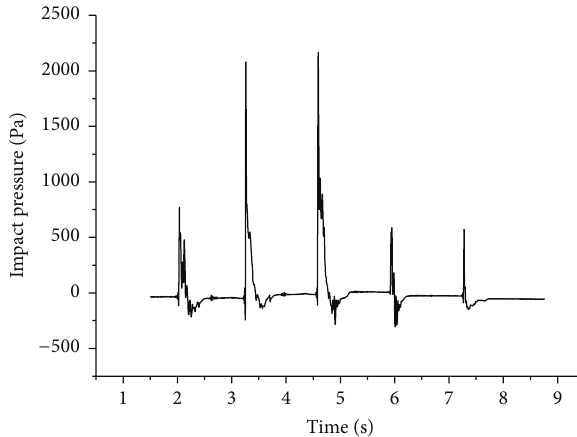
Figure 5: Time history of impact pressure about case 1 of point 4 with 24 mm amplitude.